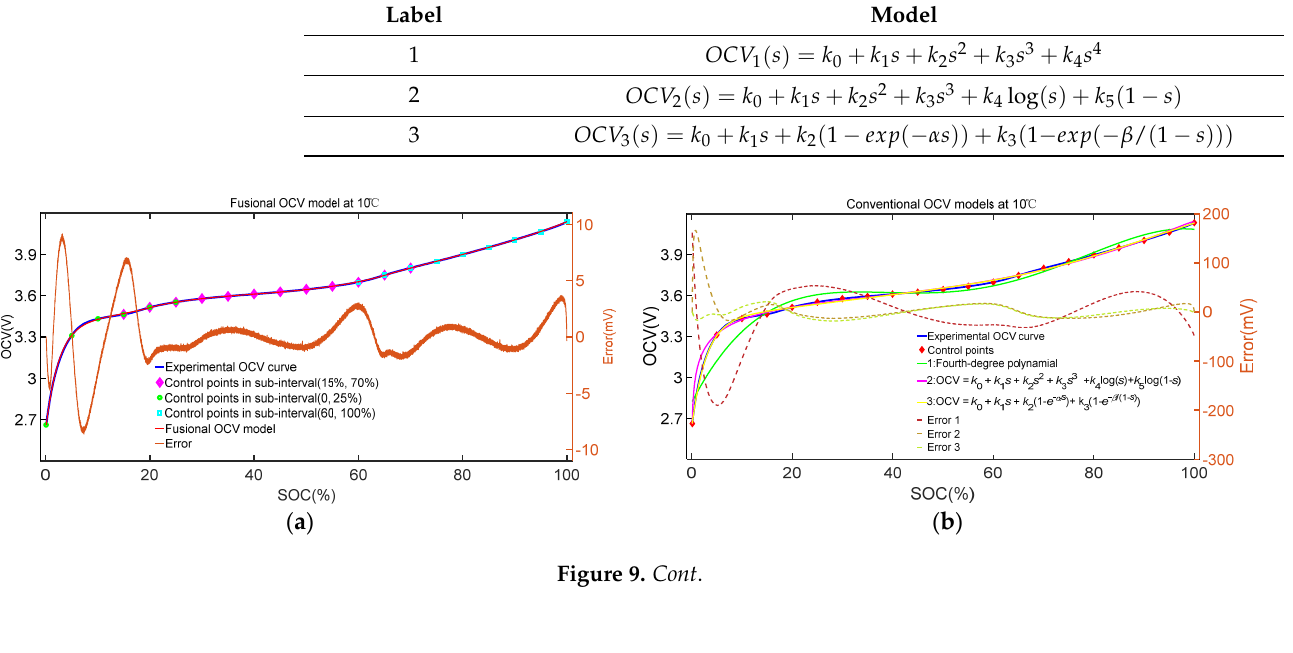
Figure 8. Current profiles of: ( a ) DST. ( b ) Cycle window of DST. ( c ) low-current OCV test. Table 3. Basis information of tested batteries.